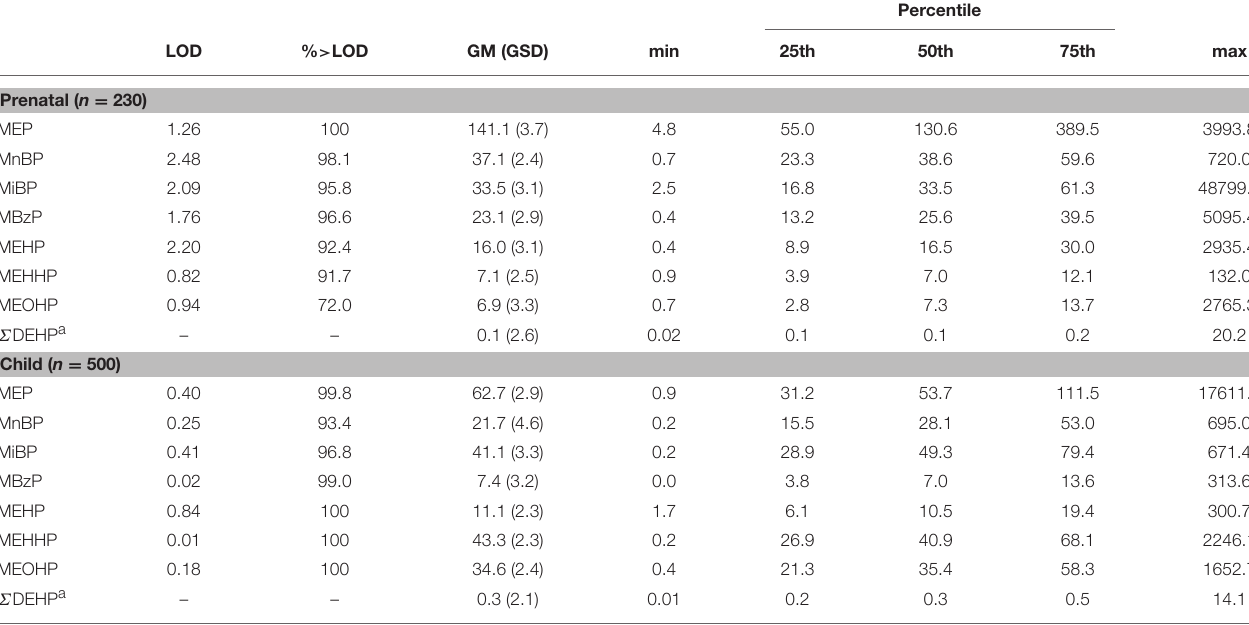
TABLE 2 | Maternal and children urinary concentrations of phthalate metabolites ( µ g/g creatinine), Mother-child cohort “Rhea” in Crete, Greece. Percentile LOD % > LOD GM (GSD) min 25th 50th 75th max